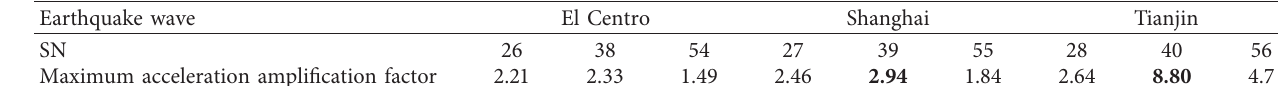
Figure 23: Envelope diagrams of the acceleration amplification factors. (a) El Centro. (b) Shanghai. (c) Tianjin. Table 9: Maximum amplification factor of the acceleration.